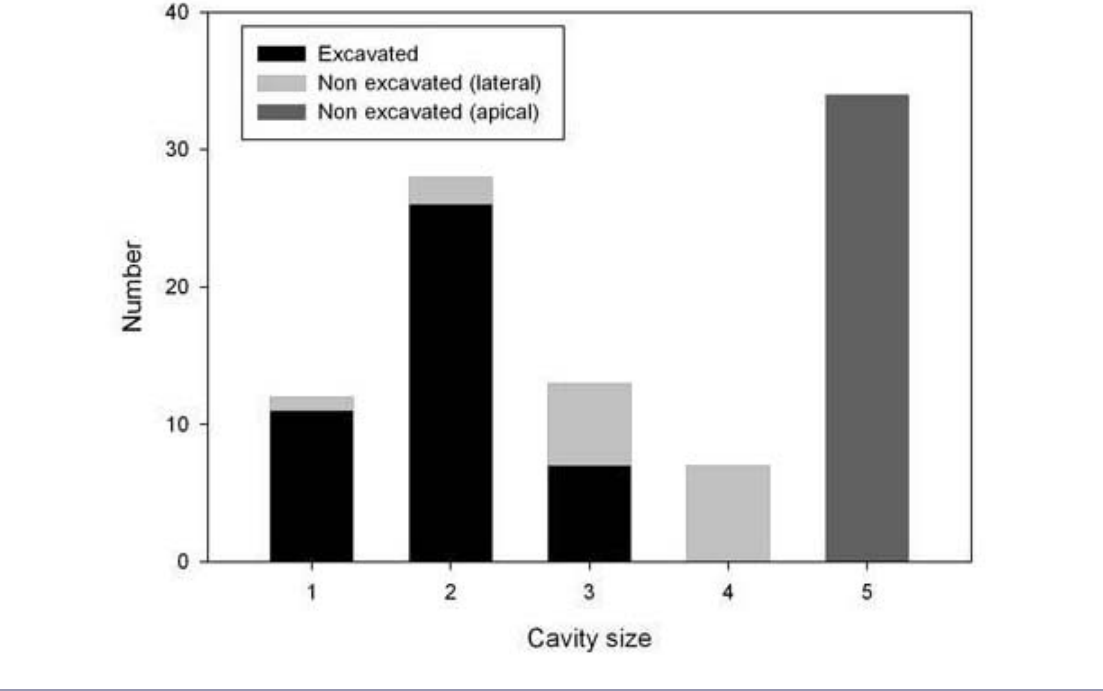
Fig. 2 . Number of cavities found for each cavity type in the Chauvin and Martin-Valin controlled wildlife harvesting zones, Quebec, Canada. 1 = small cavities, 2 = medium cavities, 3 = large cavities, 4 = very large cavities, and 5 = apical cavities. See Methods for more details on cavity size and